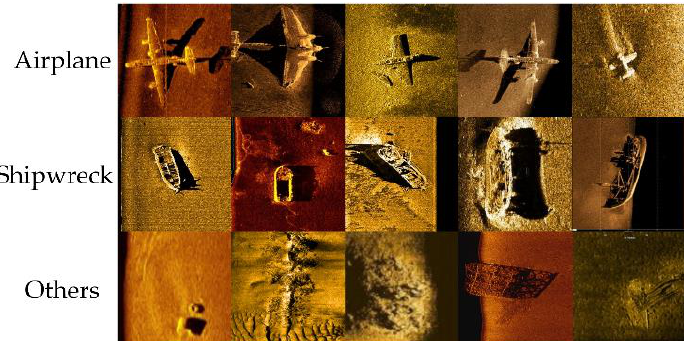
Figure 14. Examples of side-scan sonar image dataset.